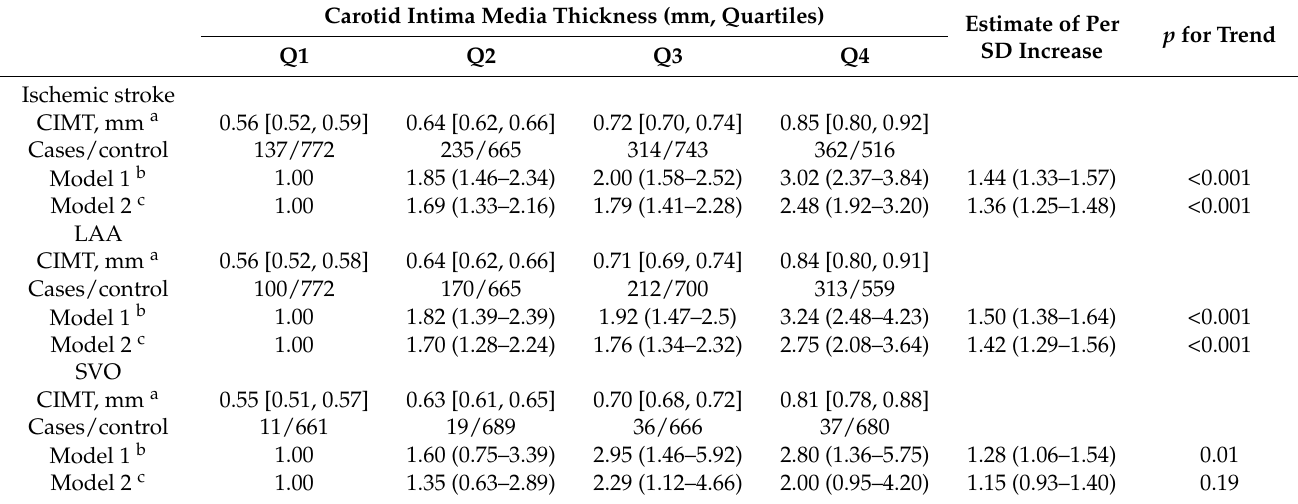
Table 2. Odds ratio and 95% confidence intervals of common carotid intima media thickness with ischemic stroke and its